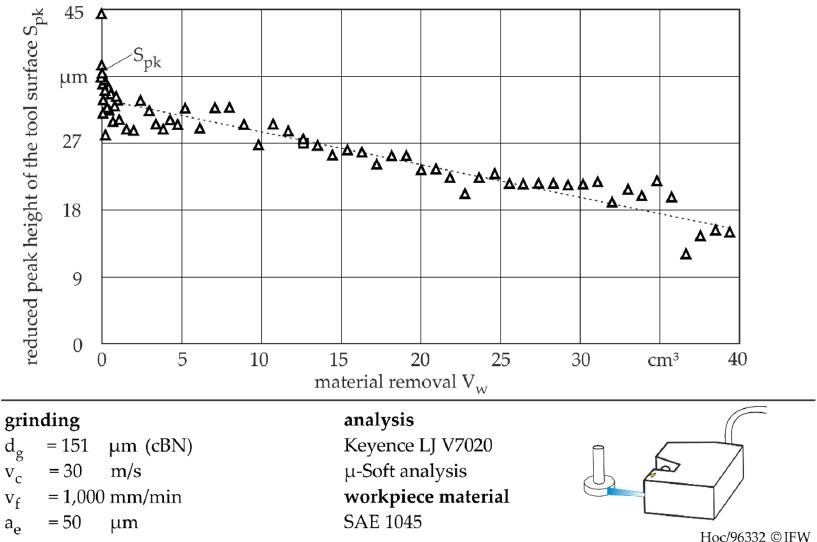
Figure 5. Reduced peak height over removed workpiece volume.